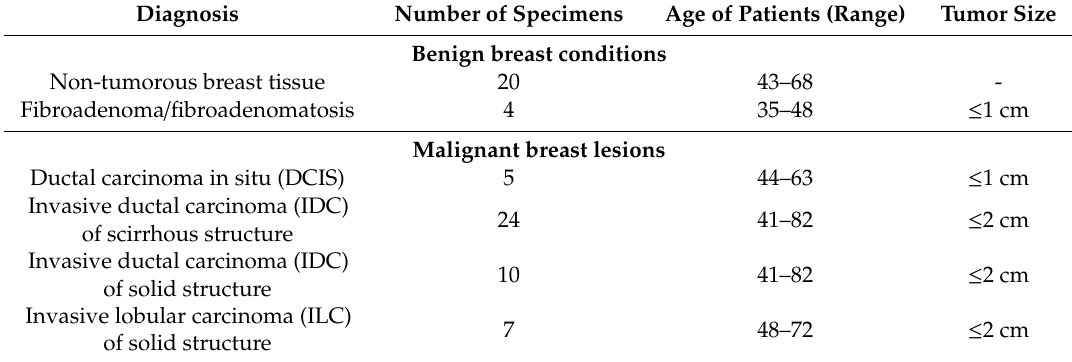
Table 1. Clinical specimens’ characteristics and number of imaged